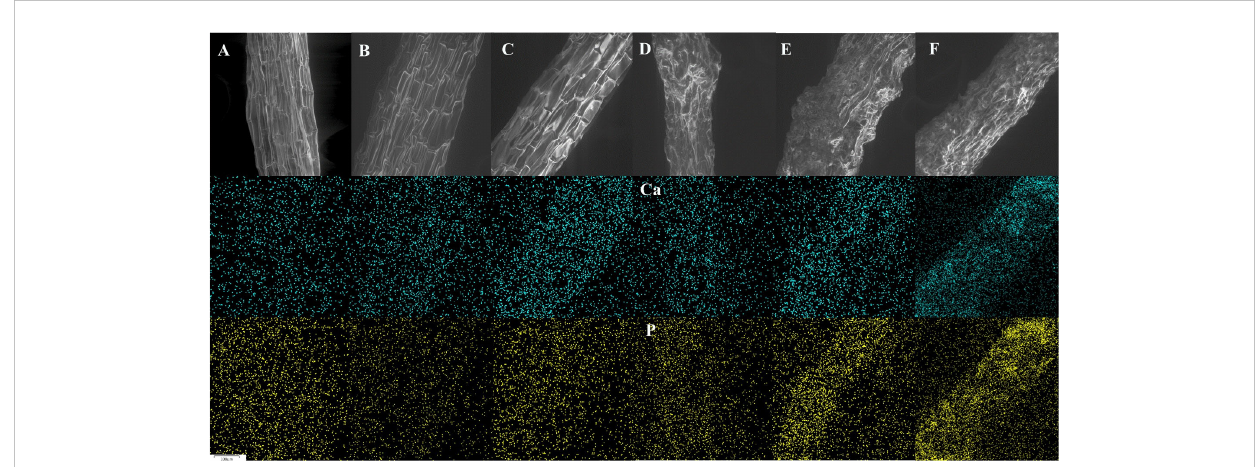
FIGURE 4 Representative SEM images (Wd = 15 mm, Hv = 19 kV, Bi = 16) of Southern highbush blueberry ( Vaccinium corymbosum , cv. Windsor) roots after 12 weeks of growth in nutrient solutions at pH 4.5 (a – c) and 7.5 (d – f) that included three different concentration of Ca: 0 (A, D) , 10 (B, E) and 100 (C, F) mg L -1 and the corresponding illustrations of their Ca and P distributions that were created by the EDS